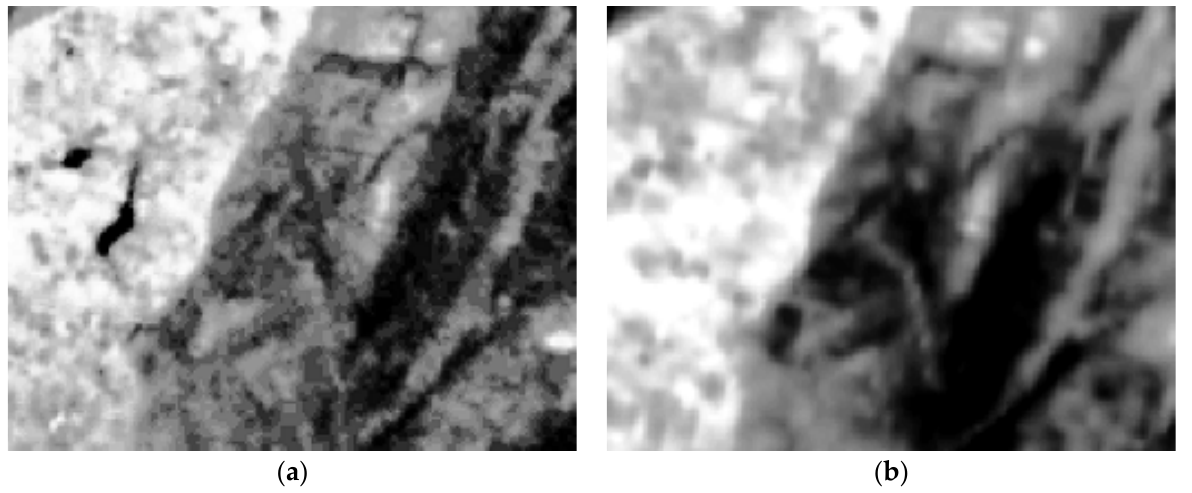
Figure 3. Preprocessed Landsat TIRS bands of Javadi Hill for the years ( a ) 2012 and ( b ) 2015.